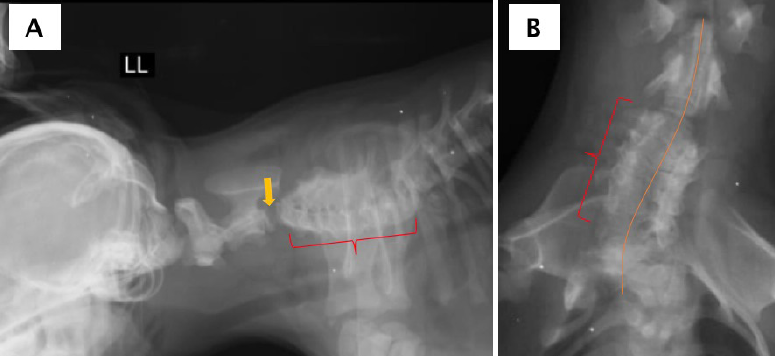
Figure 2. Radiographic images of the cervical-thoracic region of a 3-month-old male MBD dog, with congenital vertebral malformations. (Veterinary Hospital/UFRRJ – August/2019) Note. A) Lateral-lateral radiograph showing dorsal deviation of the bone axis between the C2-C3 vertebrae, with distancing of their vertebral bodies (yellow arrow), change in conformation, with shortening and remodeling of the vertebral bodies from C3 to T3 showing